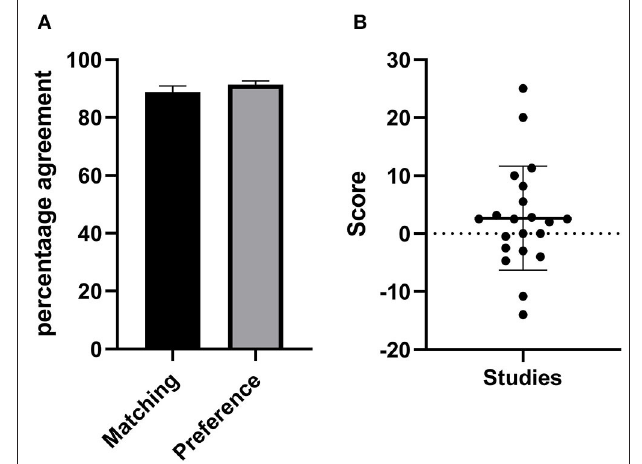
FIGURE 5 | No difference between belief in Learning Styles and Learning Preferences. (A) The percentage of participants who report believing that individuals have preferences for how the receive information, and the percentage who report believing that individuals learn better when receiving information in their preferred Learning Style. (B) The difference between these two measures, calculated for individual samples. A negative score means that fewer participants believed that students have preferences for how they received information compared to the percentage who believed that matching instruction to Learning Styles is